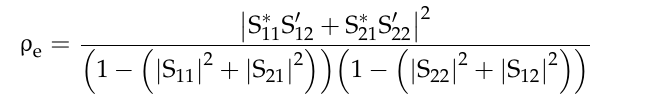
Figure 10. Radiation polarization of the proposed antenna. ( a ) 2.4 GHz E-plane; ( b ) 2.4 GHz H-plane; ( c ) 5.5 GHz E-plane; ( d ) 5.5 GHz H-plane.